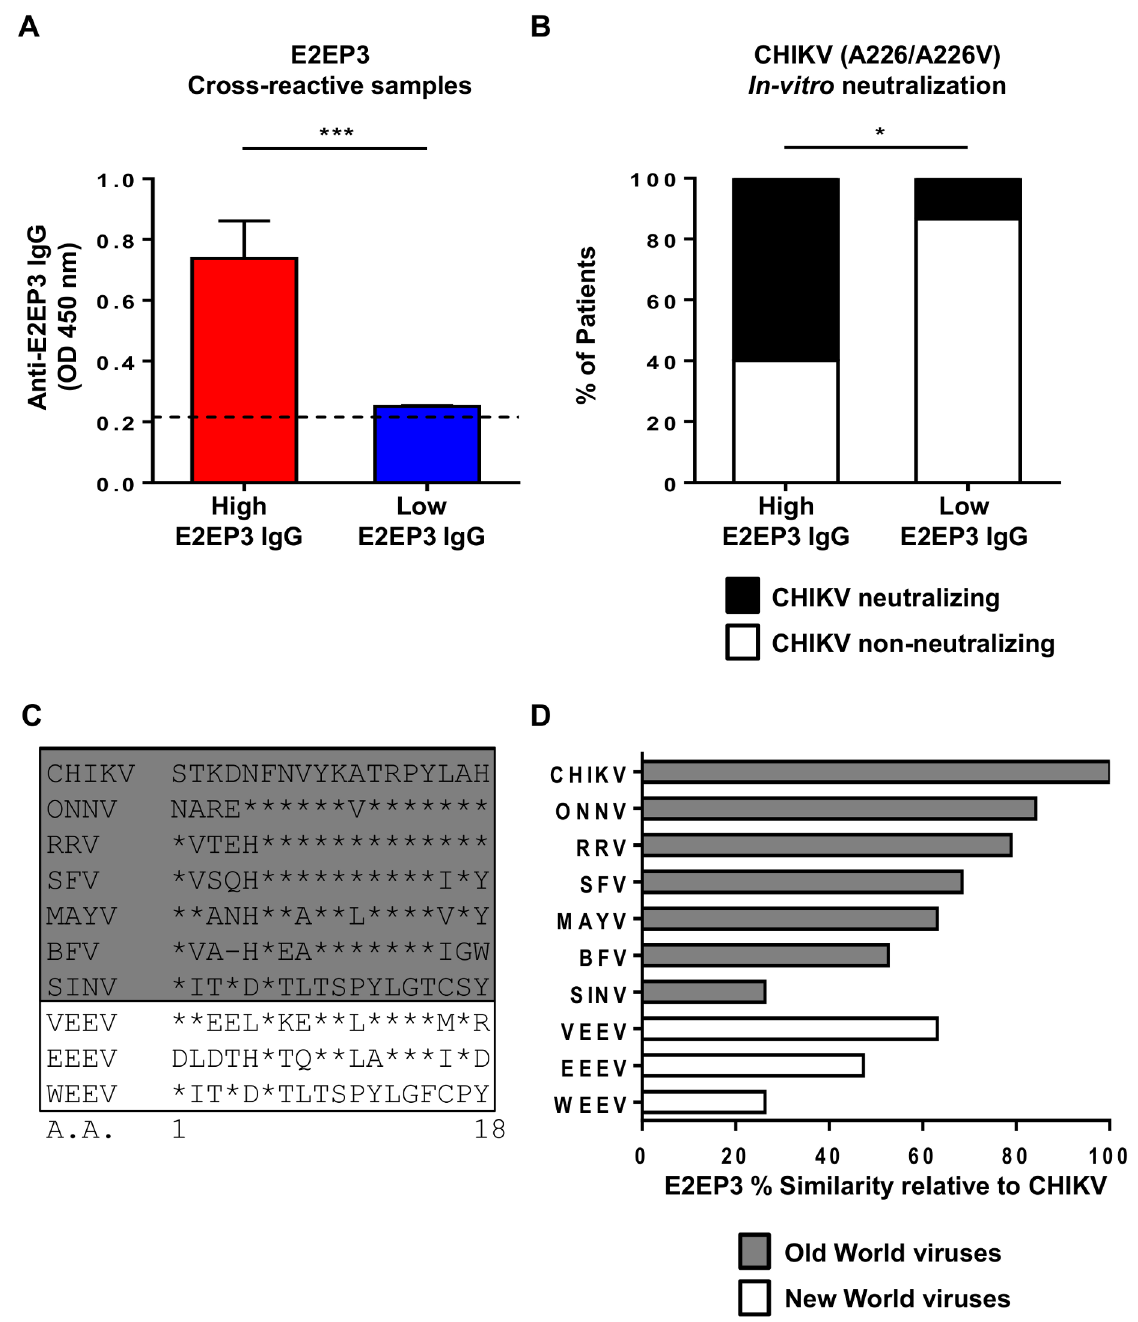
Fig. 3. Association of E2EP3 cross-reactive antibody responses with CHIKV neutralizing activity. A, Anti-E2EP3 antibody response in serum samples (High E2EP3 IgG responders, n=10; Low E2EP3 IgG responders, n=15), at a dilution of 1:4,000 were determined by ELISA using biotinylated E2EP3 peptides. Data are presented as mean 6 SEM. Data are representative of two independent experiments with similar results. Statistical significance was measured using Mann-Whitney U test (*** P , 0.0001). B, In-vitro neutralizing activity against CHIKV in High and Low E2EP3 IgG responders. Histogram shows the percentage of patient samples with or without CHIKV neutralizing activity. Statistical significant was measured using 2-sided Fisher exact test between the patient samples with and without CHIKV neutralizing activity in the 2 responder groups. * P =0.028. C - D, E2EP3 sequence from CHIKV was aligned to corresponding sequences from 9 non-CHIKV alphaviruses (ONNV, RRV, SFV, MAYV, BFV, SINV, VEEV, EEEV and WEEV). Conserved amino acid (A.A.) are indicated by a *. Percentage similarity between CHIKV E2EP3 sequence and corresponding sequence from each non-CHIKV alphavirus were calculated with SIAS (http://imed.med.ucm.es/Tools/sias.html). Percentage similarity relative to CHIKV E2EP3 is indicated by a bar-chart. Viruses classified as Old World alphaviruses are marked by the grey shading box, while viruses classified as New World alphaviruses are marked by the white box. NCBI Genbank accession numbers of ten selected alphaviruses (CHIKV - DQ443544, ONNV - O90369, RRV - AEC49728, SFV - ABA29033, MAYV - AAL79764, BFV - NP819000, SINV - ACU25462, VEEV - AAB02519, EEEV - NP740646, WEEV - NP818940).